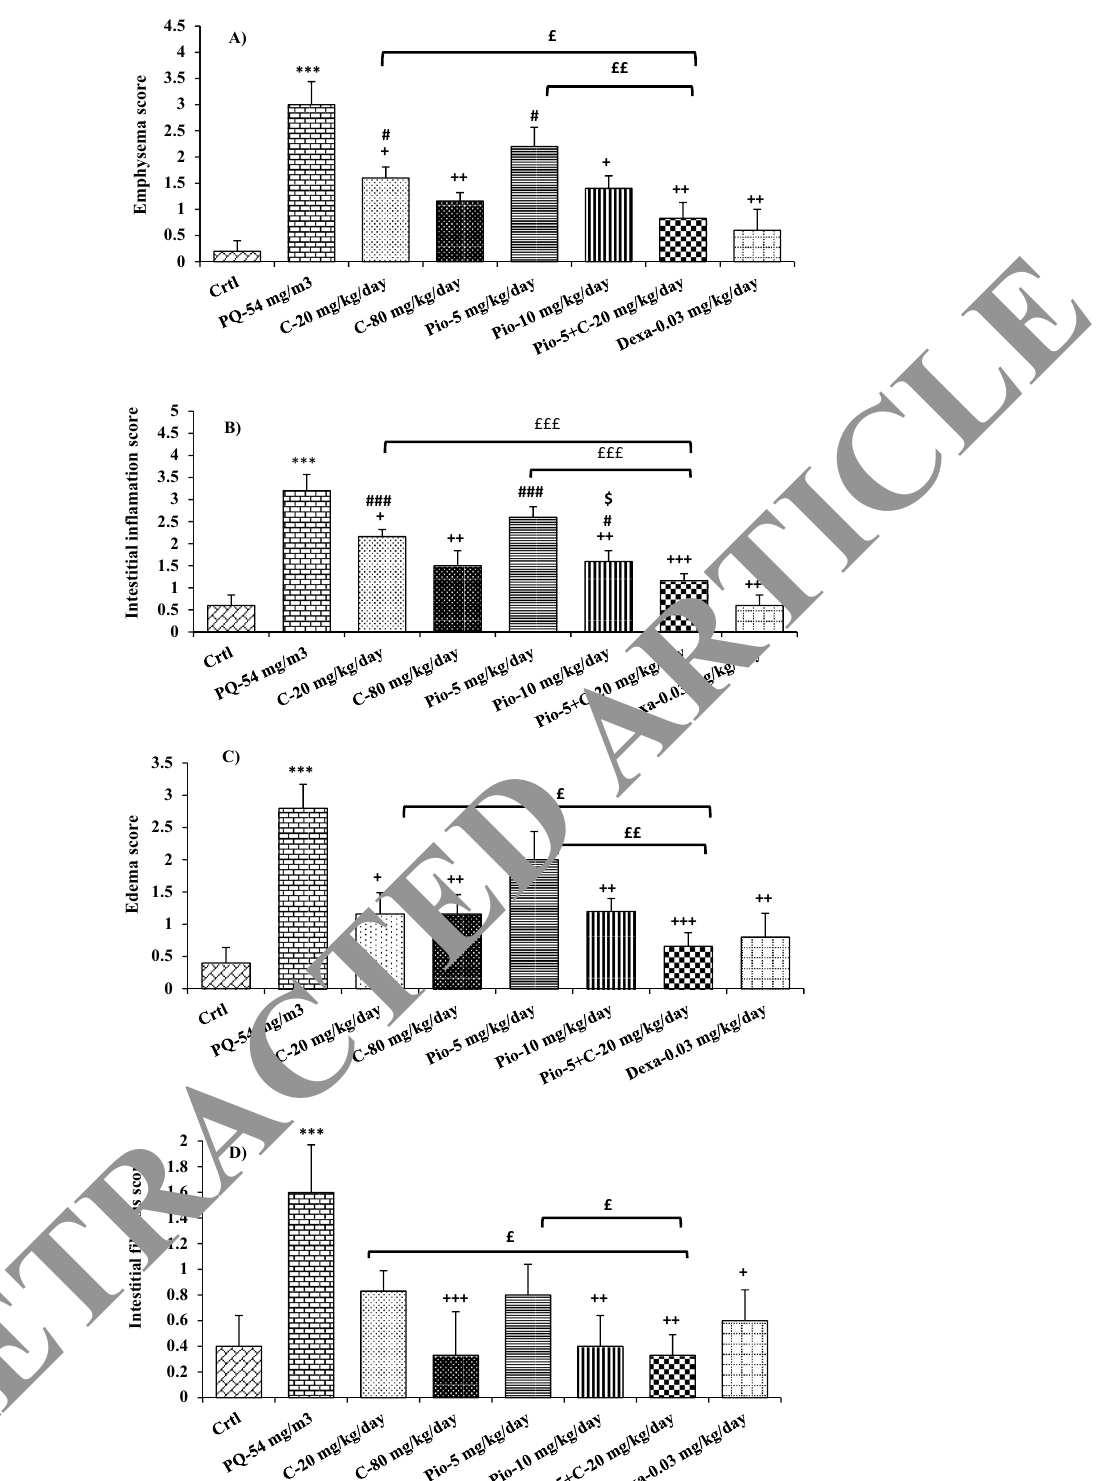
Figure 2. Comparisons of emphysema ( A ), interstitial inflammation ( B ), edema ( C ) and interstitial fibrosis ( D ) between control group (Ctrl), group exposed to paraquat aerosol at doses of 54 mg/m 3 (PQ-54 mg/m 3 ), groups exposed to PQ-54 mg/m 3 and treated with 5 and 10 mg/kg/day pioglitazone (Pio-5 mg/kg/day and Pio-10 mg/kg/day), 20 and 80 mg/kg/day carvacrol (C-20 mg/kg/day and C-80 mg/kg/day), 0.03 mg/kg/day dexamethasone (Dexa-0.03 mg/kg/ day) and 5 mg/kg/day pioglitazone + 20 mg/kg/day carvacrol (Pio-5 mg/kg + C-20 mg/kg). *** p < 0.001 compared to the control group. + p < 0.05, ++ p < 0.01, and +++ p < 0.001 compared to PQ-54 mg/m 3 , # p < 0.05 and ### p < 0.001 compared to dexamethasone, $ p < 0.05 co mpared to Pio-5 mg/kg/day, £ p < 0.05, ££ p < 0.01and £££ p < 0.001 co mparison between C-20 and Pio-5 with Pio-5 mg/kg/day + C-20 mg/kg/day group. Data are presented as mean ± SEM (n = 6 in each group). Comparisons between different groups were made using one-way ANOVA followed by Tukey’s multiple comparison